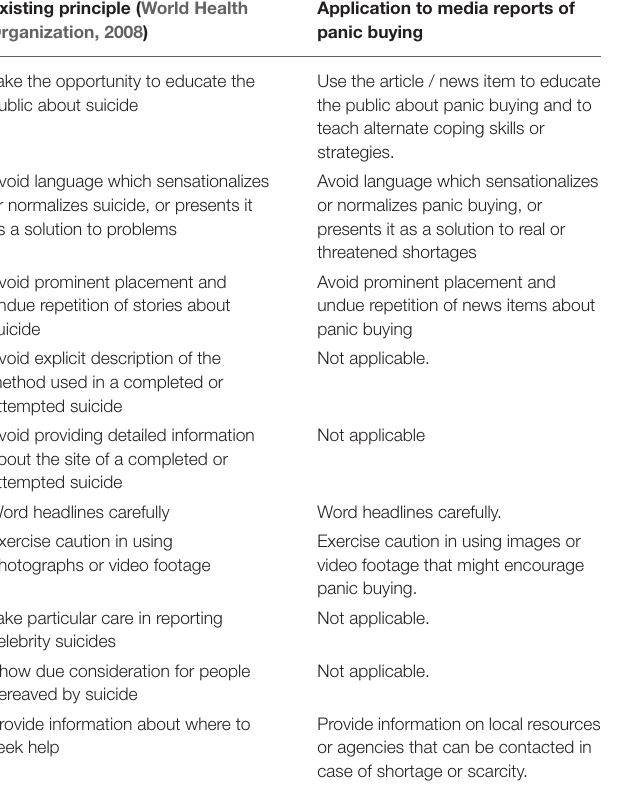
TABLE 1 | Existing media guidelines on suicide reporting and their relevance to panic buying. Existing principle (World Health Organization, 2008)